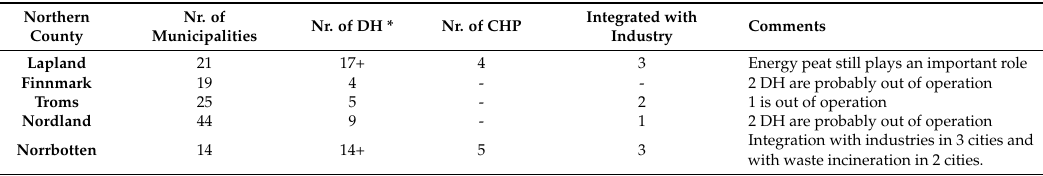
Table 10. Counties, municipalities, nr of DH systems, nr of CHP plants in DH, nr of integrated DH systems with